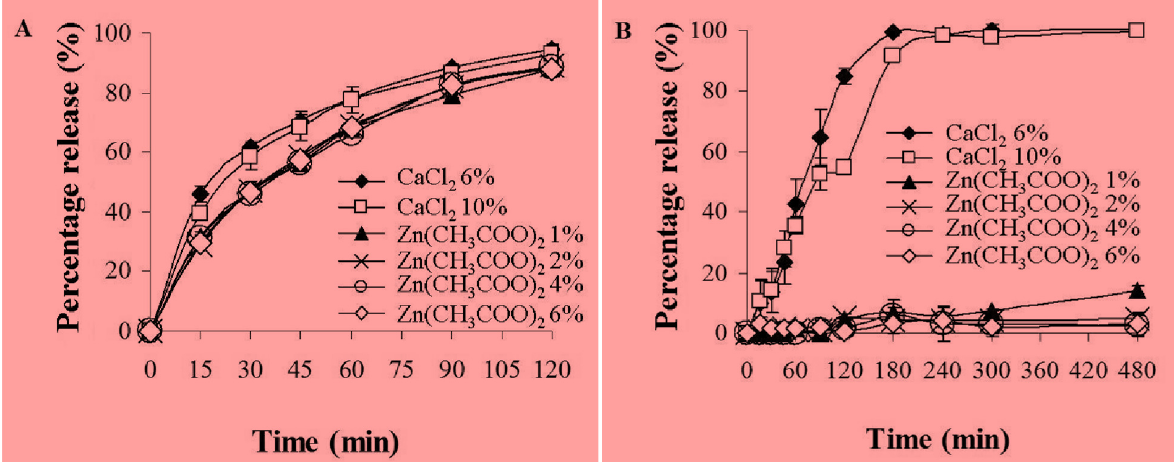
Figure 3. Effects of the type of cross-linker (CaCl concentration on the release of MSKE from CPG and ZPG beads determined after incubation in SGM for 2 h ( A ) and SIM for 8 h ( B ) at 37 °C. Data are presented as the mean ± SD of three determinations.